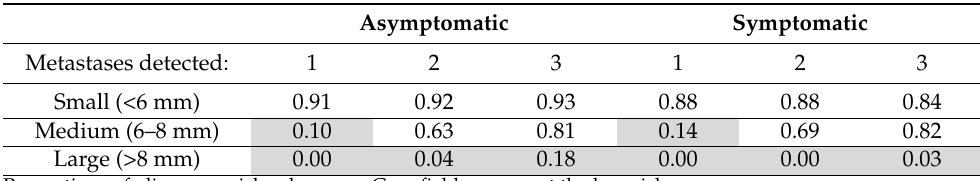
Table A4. Proportion of oligo+ within patients with detected oligo-metastases in the RFS Upper scenario.